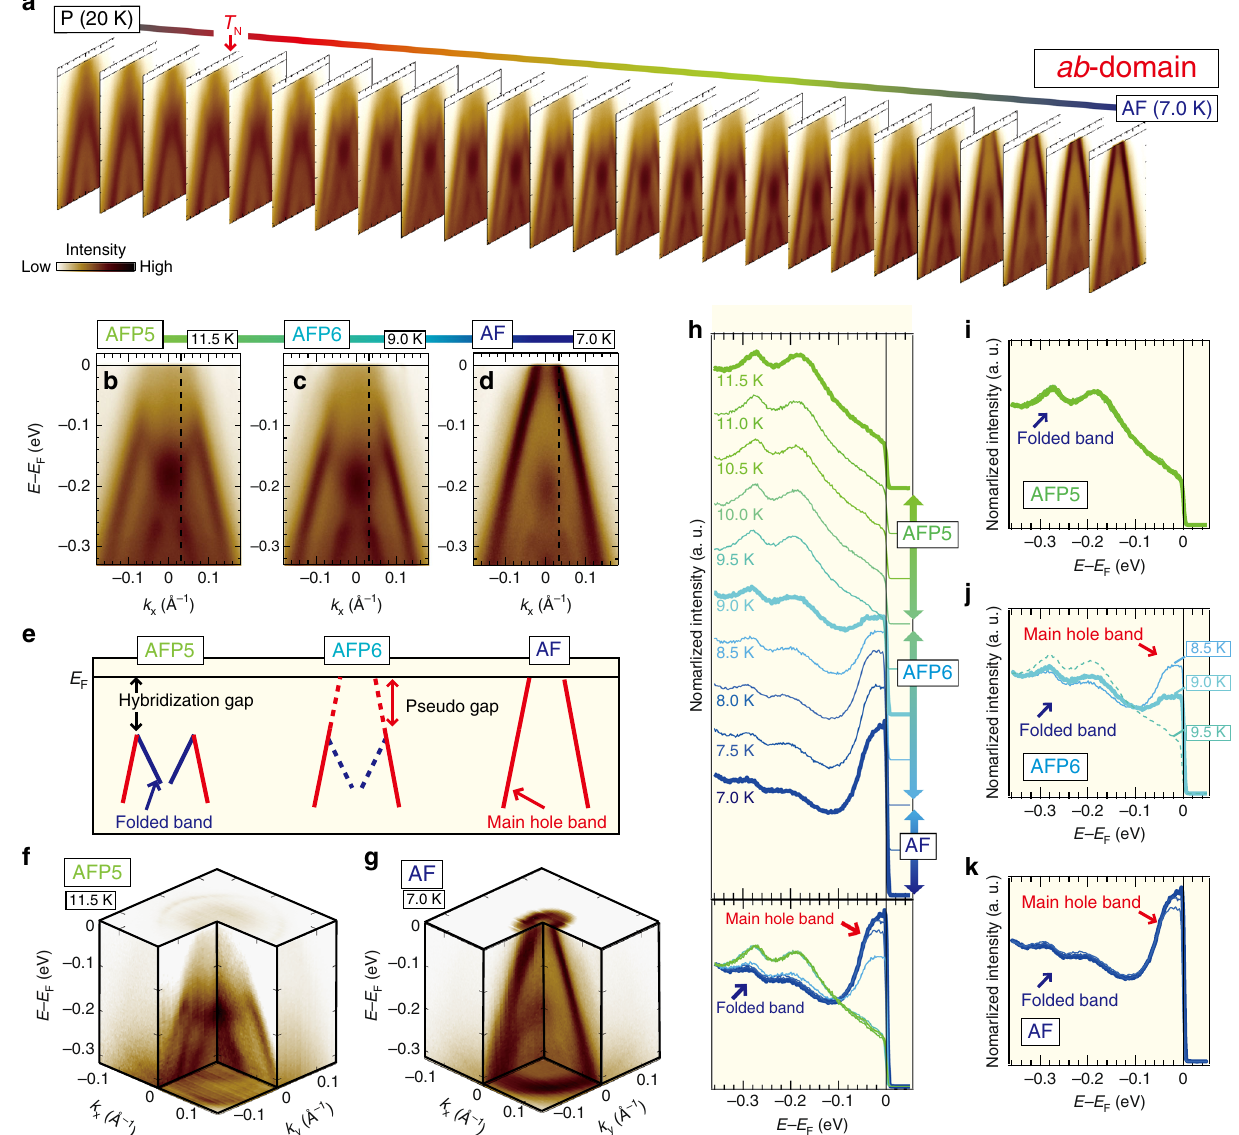
Fig. 5 Collapses of the quasiparticle coherence at E F . a Temperature evolution of the laser-ARPES images for ab -domain from 20 K (P phase) to 7.0 K (AF phase) by a 0.5 K step (see also Supplementary Movie 1). b – d The laser-ARPES images around E F at the representative phases. e The schematics of the observed evolution of (red line) the main hole band dispersion and (blue line) the folded band appeared around E − E F = 0.12 eV in AFP5 phase. f , g The three-dimensional ARPES images at 11.5 K (AFP5 phase) and 7.0 K for (AF phase), respectively. h Temperature evolution of the spectral shape in the energy distribution curves (EDCs) cut at a + k x point of the hole band at AF phase (black dashed line in b – d ). In the top and bottom panels, the data are displayed with and without an offset, respectively. The representative EDCs corresponding to the different phases are highlighted in bold lines. i – k The EDCs at various temperatures for each